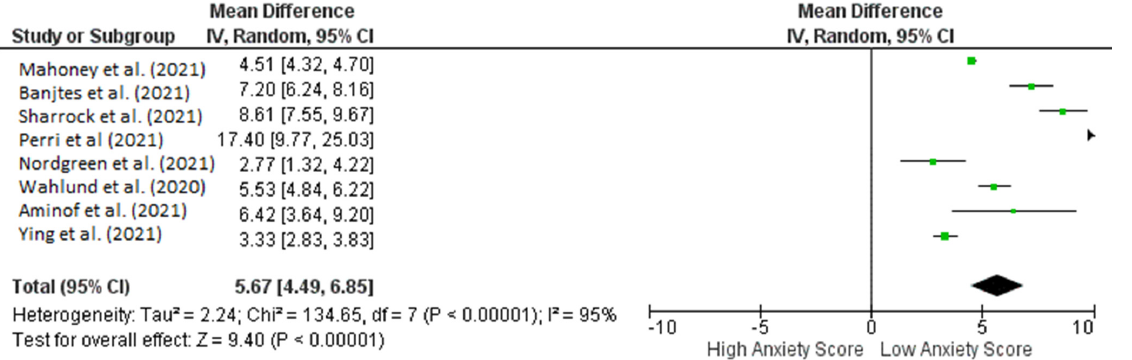
Figure 3. Forest plot pre- and post-Intervention of ICBT in achieving low anxiety scores in anxiety patients during COVID-19 pandemic.